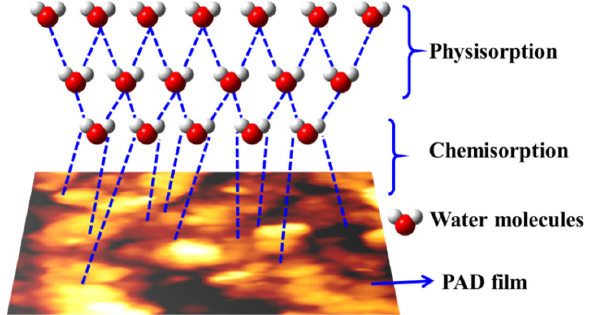
Figure 7. Schematic illustration of humidity sensing mechanism.